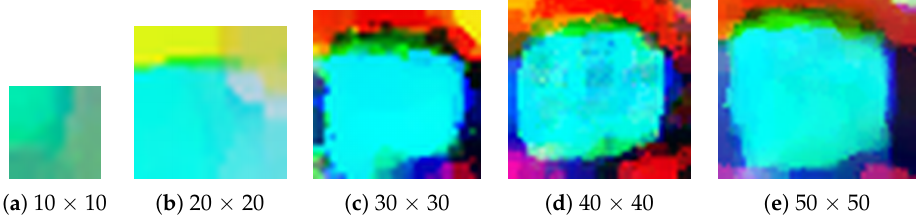
Figure 4. Visual effect of adversarial patches of different sizes. From left to right, the visualization results of the adversarial patches of size 10 × 10, 20 × 20 . . . 50 ×